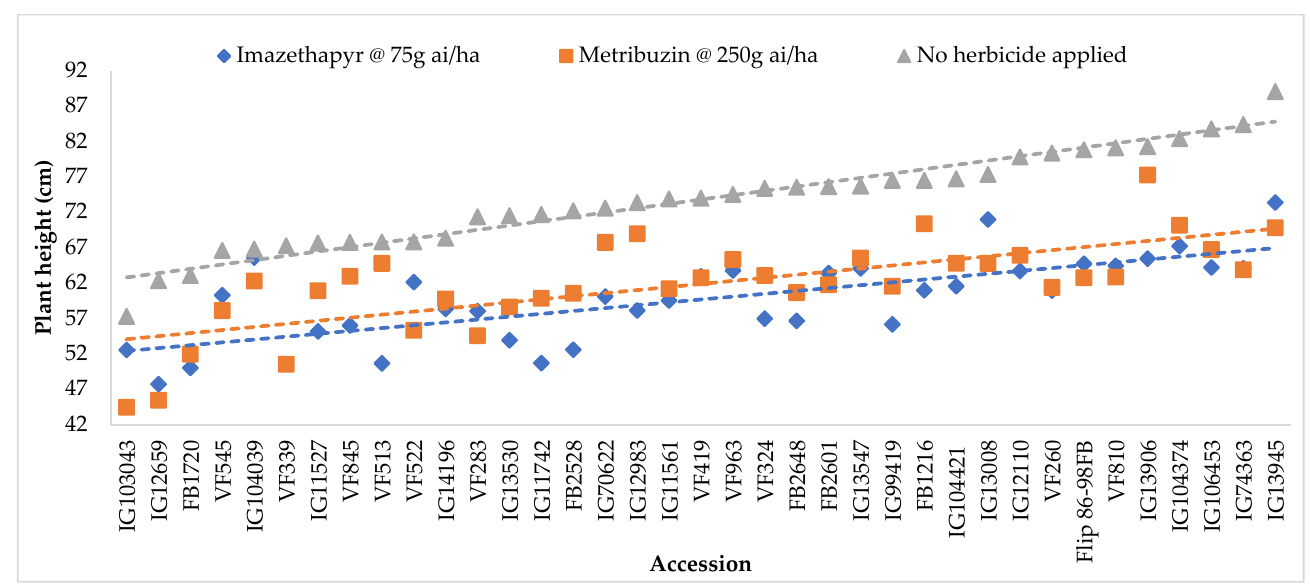
Figure 1 . Mean plant height (cm) of studied accessions of faba bean across seasons–locations under imazethapyr, metribuzin and no herbicide application treatments (SE = 5.149). Table 3 . Wald statistics performed estimates for detecting differences among faba bean genotypes and narrow sense heritability of plant height and grain yield across environments.